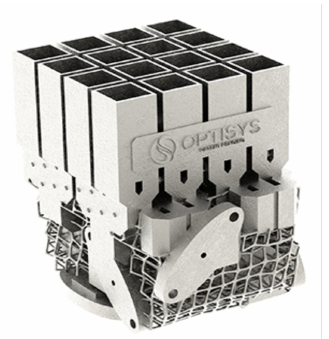
Figure 8. Lightweight AM antenna